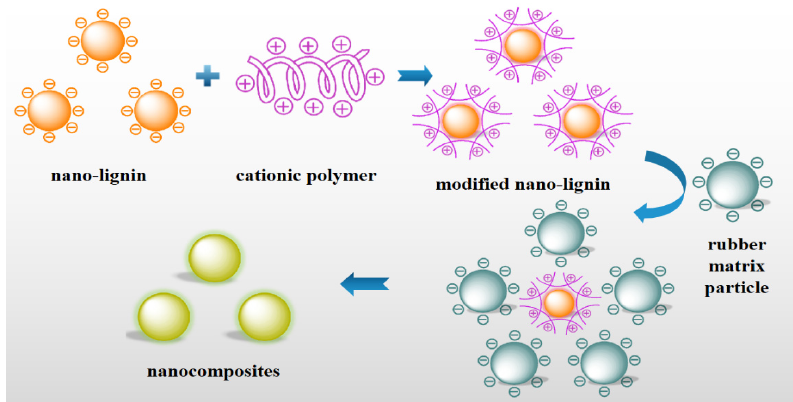
Figure 6. Preparation of nanocomposites of modified nano-lignin and rubber matrix.